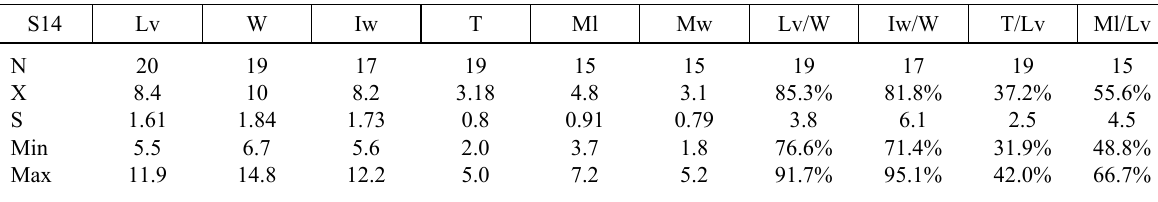
Table 1. Basic statistics of 20 ventral valves of Isorthis ( Ovalella ) inflata sp. nov.; Llandovery, mid-late Aeronian, Niur Formation, sample S14, Derenjal Mountains